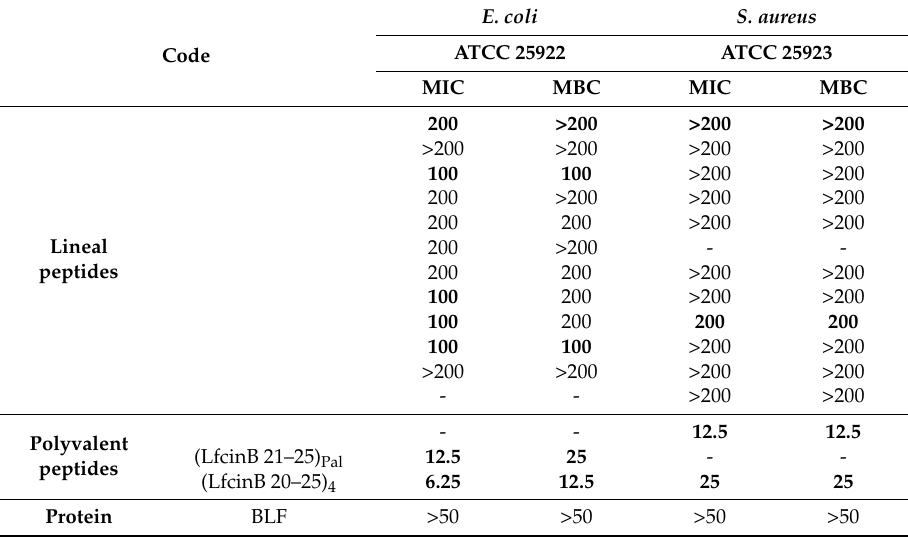
Table 2. Antibacterial activity of designed peptides derived from LfcinB